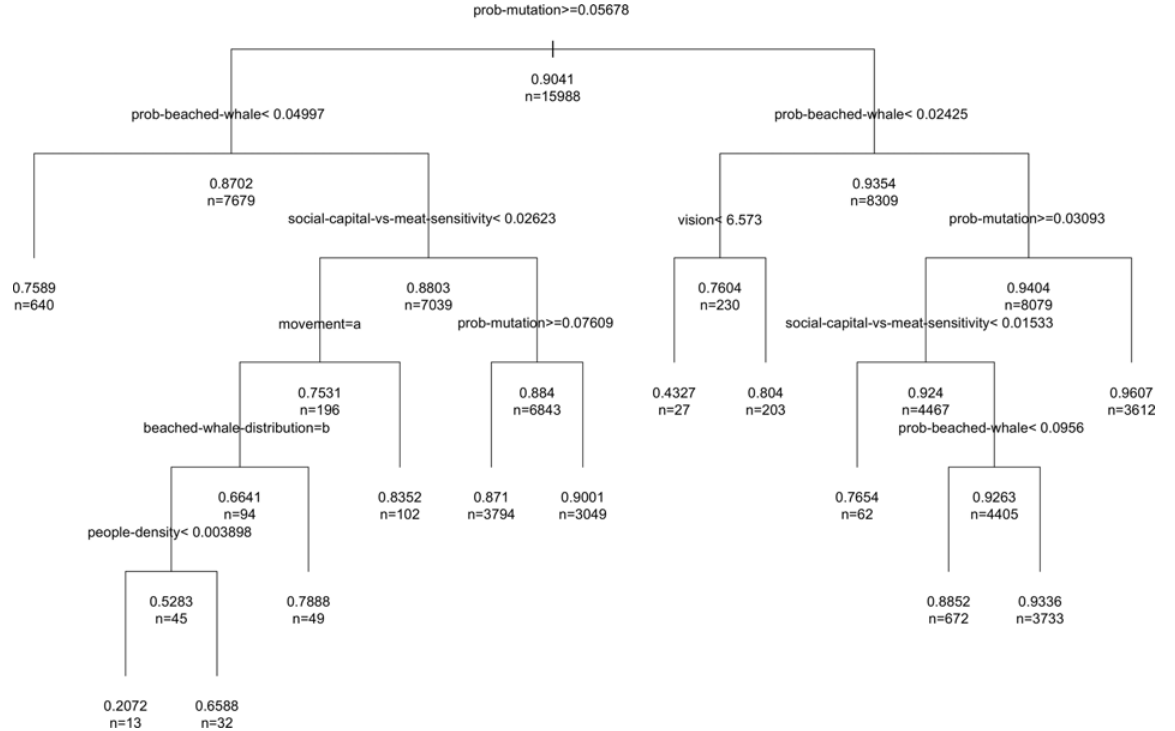
Fig 4. Pruned regression tree for average cooperation within the time limit. The CART uses the LHS data. Each decision node shows the condition used to divide the data, along with the number of runs after the split and the corresponding average of cooperation. The resulting subset on the left side satisfies the conditions while the subset on the right side does not. The maximum CART has been pruned with minsplit = 20 (i.e. the minimum number of observations that must exist in a node to try a split) and cp = 0.01 (i.e. complexity parameter).